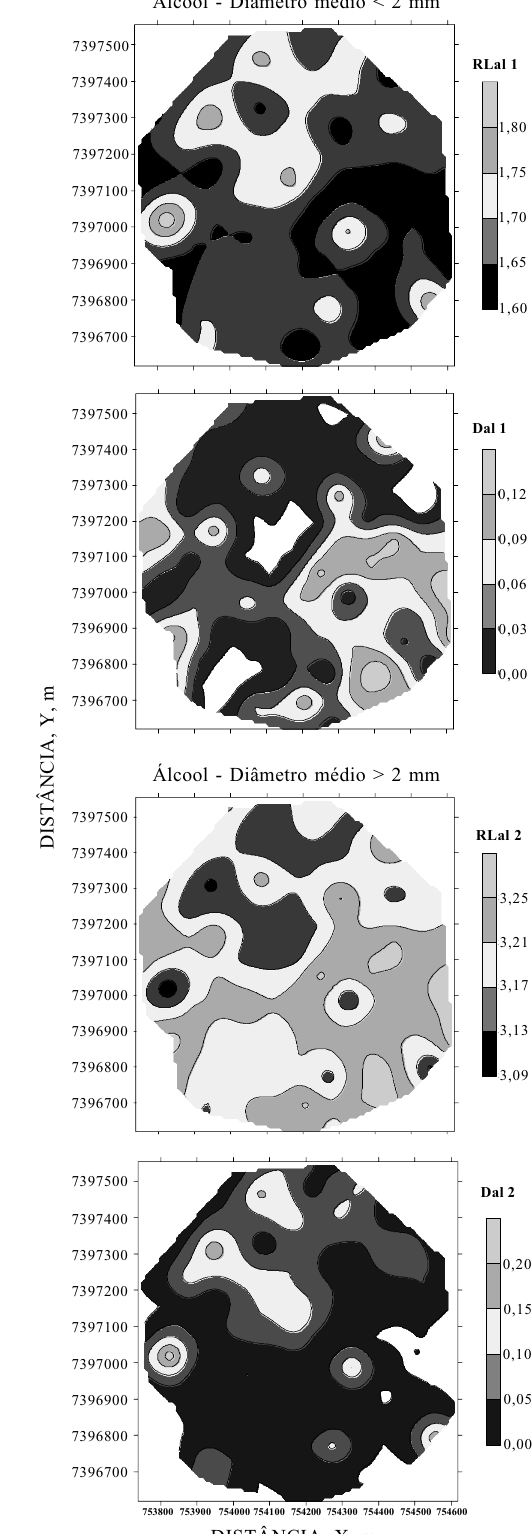
Figura 4. Mapa de contorno usando krigagem ordinária para o maior tamanho de agregado R e para a dimensão da massa fractal D no L pré-tratamento com água.